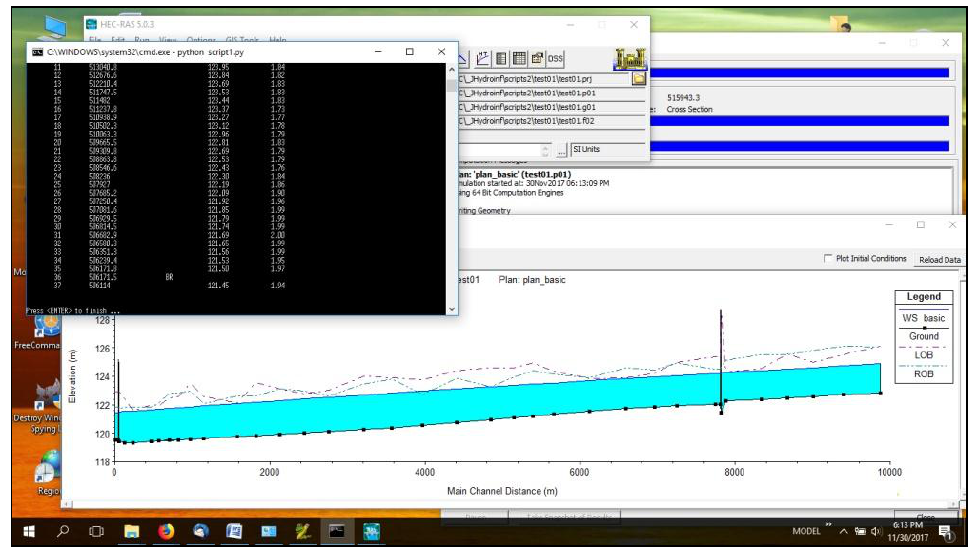
Figure 2. Run of Example 1 and display of results.